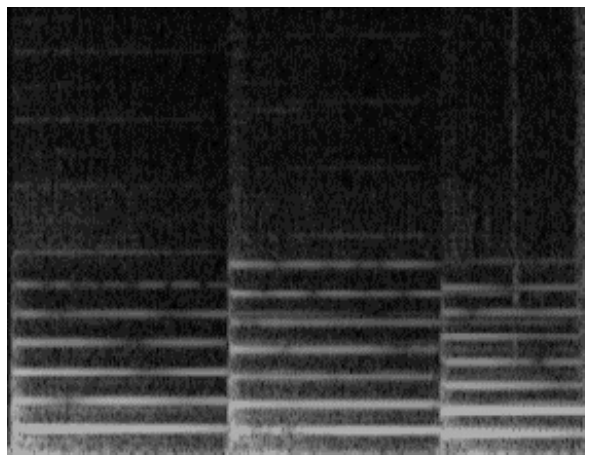
Figure 21. The spectrogram of the signal restored by four components.